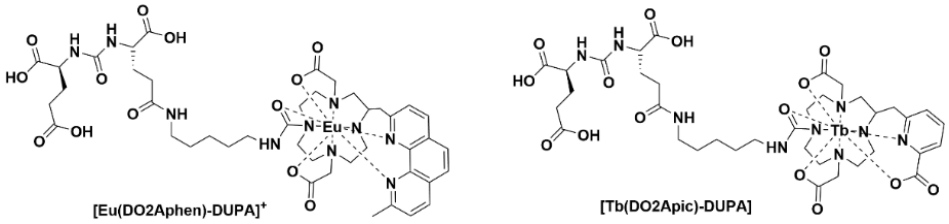
Figure 7. Chemical structures of [Eu(DO2Aphen)-DUPA] + and [Tb(DO2Apic)-DUPA].